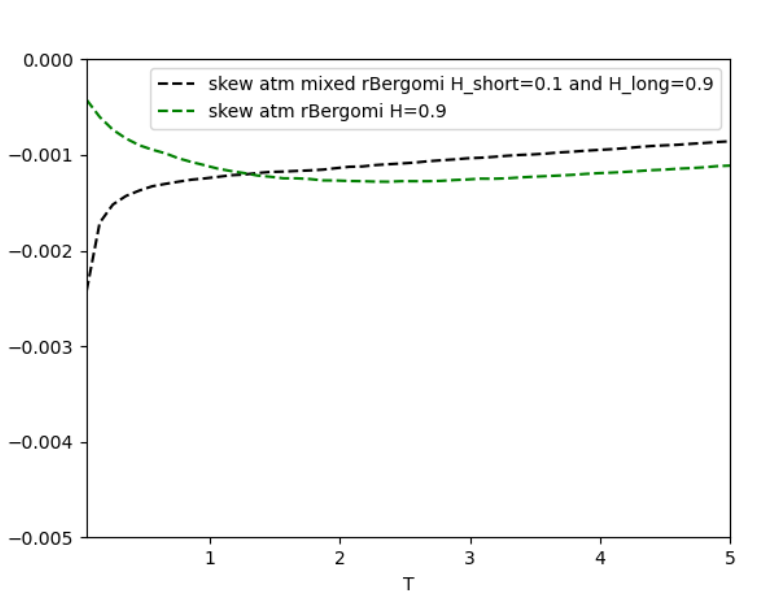
Figure 6. Slope skew for an mfBergomi model and an fBergomi model with H (cid:48) > 1